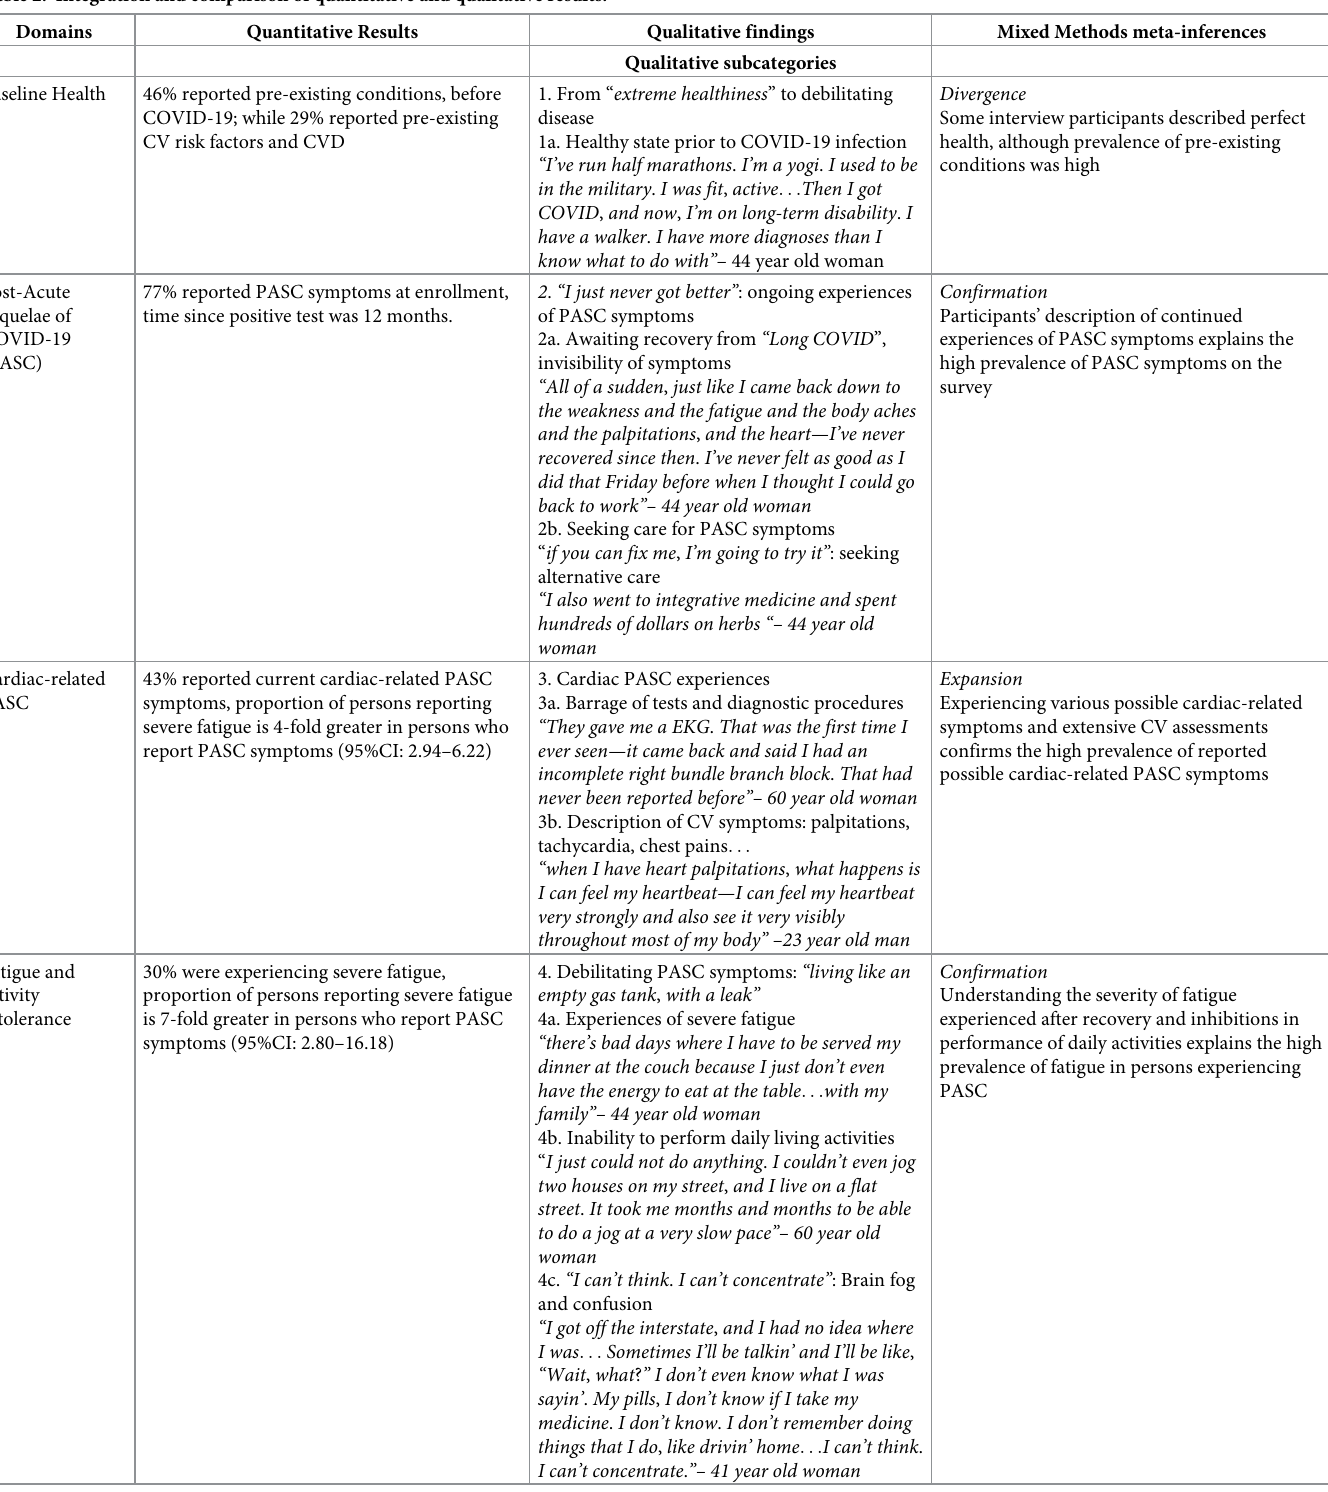
Table 2. Integration and comparison of quantitative and qualitative